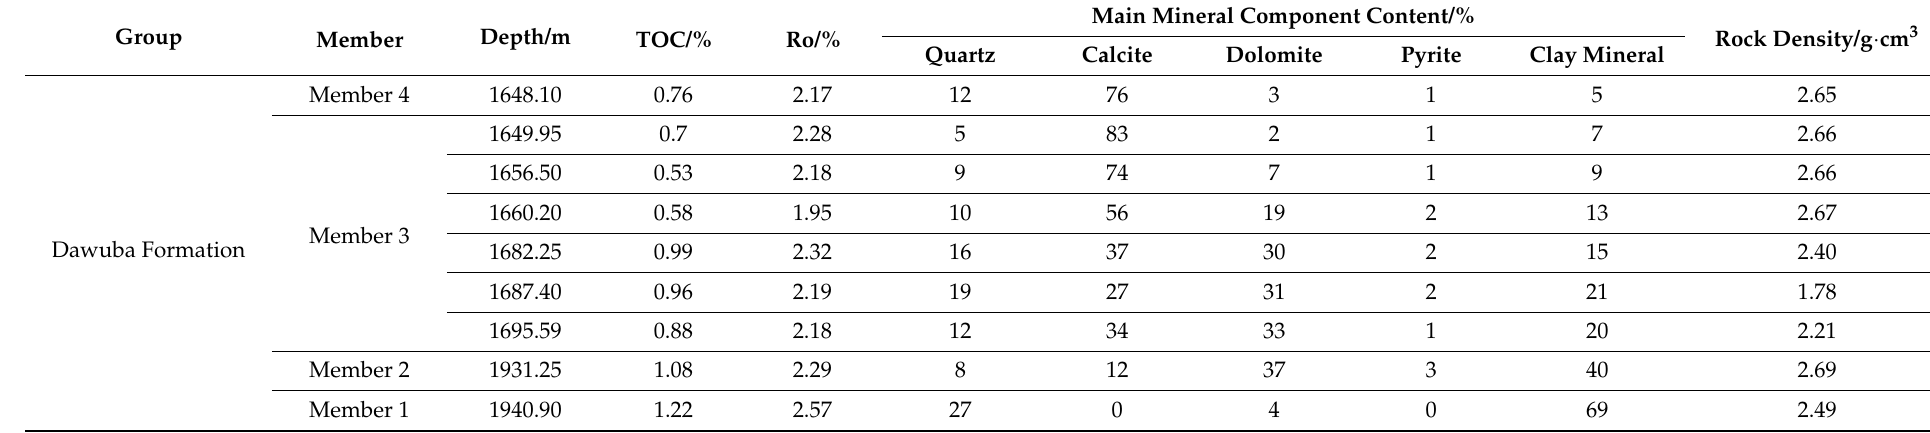
Table 1. Shale sample parameters of the Dawuba Formation in the Qianxi